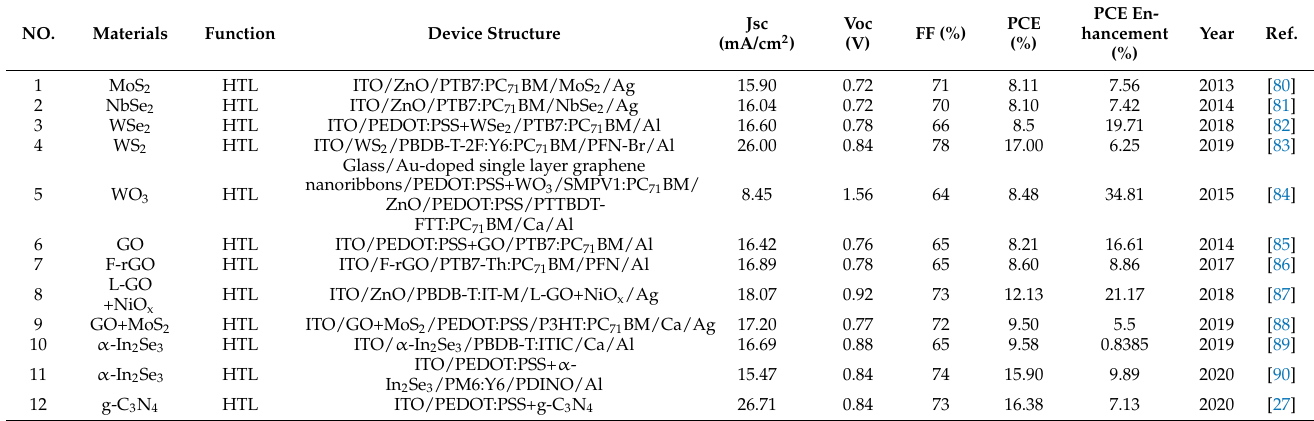
Table 3. 2D layer materials incorporated into